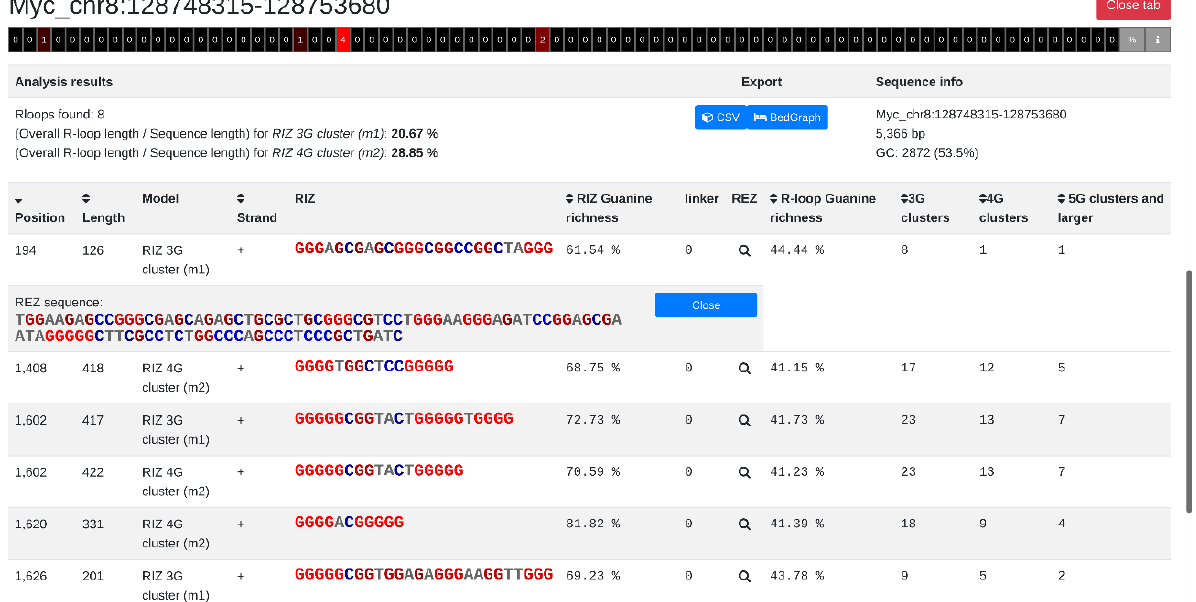
Figure 1. Example of an R-loop tracker result, analysis of Myc gene location on human chromosome 8.